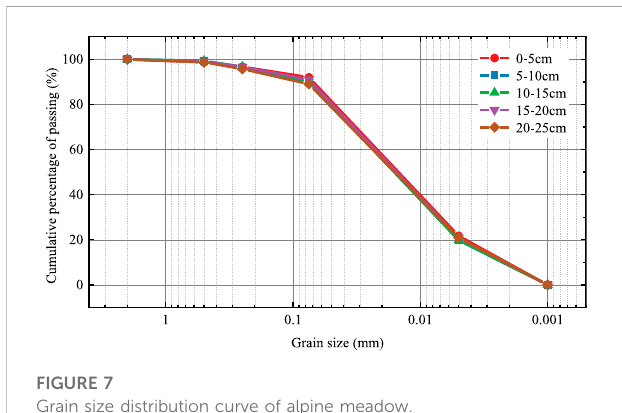
FIGURE 7 Grain size distribution curve of alpine